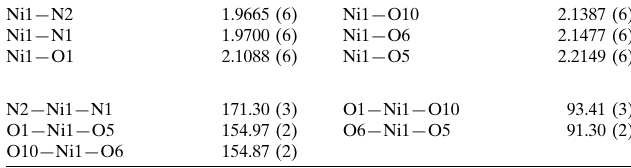
Selected geometric parameters (A˚ , (cid:3) ).